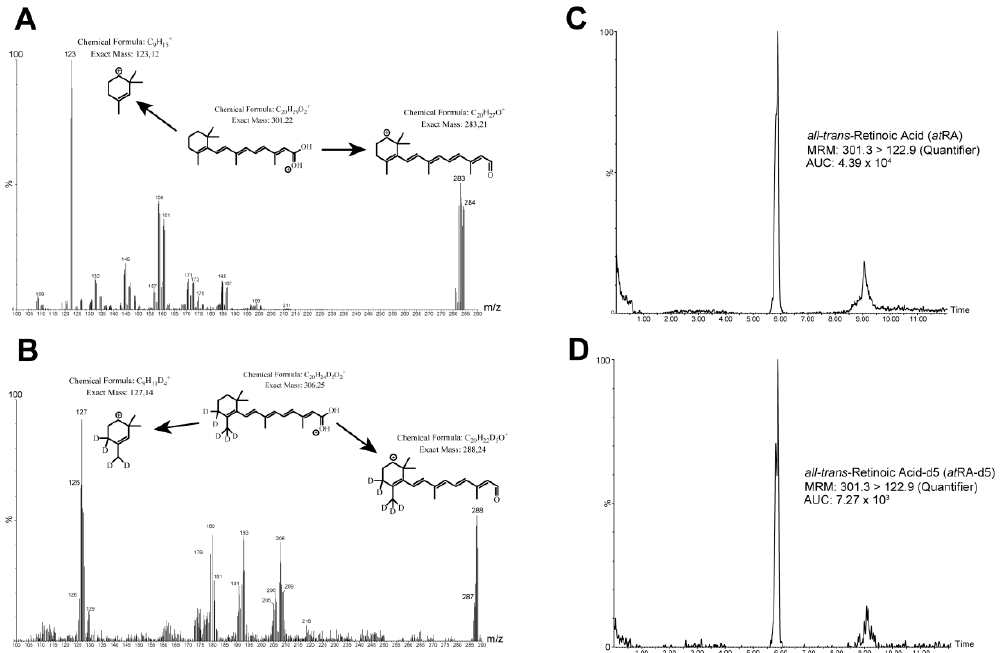
Figure 2. Multiple reaction monitoring (MRM) chromatograms and total ion chromatograms of at RA/ at RA-d5. ( A ) Extracted MRM spectrum (quantifier/qualifier) of at RA. ( B ) Extracted MRM spectrum (quantifier/qualifier) of atRA-d5. ( C ) Total ion chromatogram of at RA in a control subject (1.02 ng · mL − 1 ). ( D ) Total ion chromatogram of at RA-d5 in the same control subject as in ( C ).